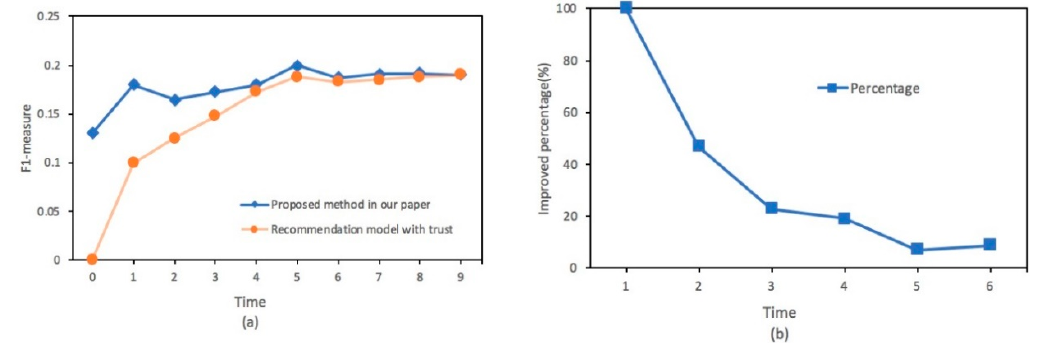
Figure 3. The result of the experiment. ( a ) The results of F 1-measure in a health and personal care shop; ( b ) the percentage of improvement of F 1-measure in the health and personal care shop.